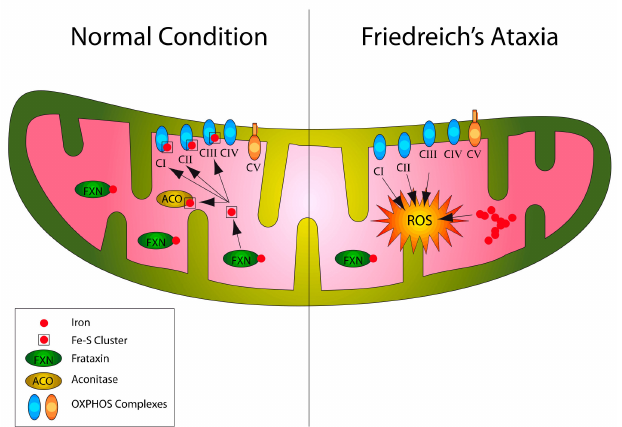
Figure 1. Overview of Friedreich’s ataxia deregulations following frataxin expression deficiency. Frataxin depletion determines iron accumulation in the mitochondrion, impairments of Fe–S proteins, increased reactive oxygen species (ROS) accumulation and oxidative